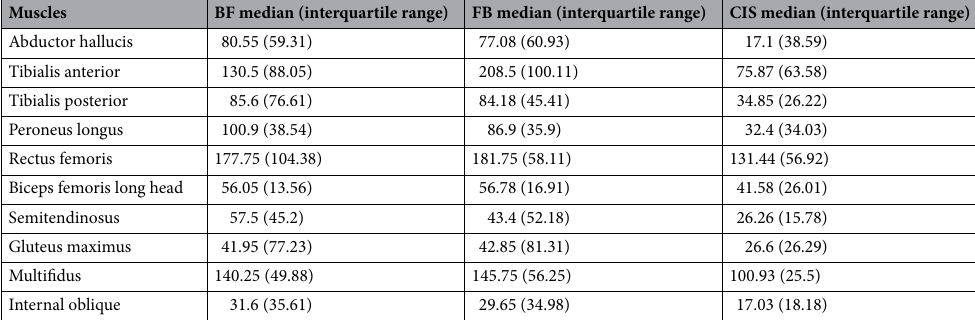
Table 2. The activity of each muscle in BF, FB and CIS. BF back-to-front, FB front-to-back; CIS conventional isometric